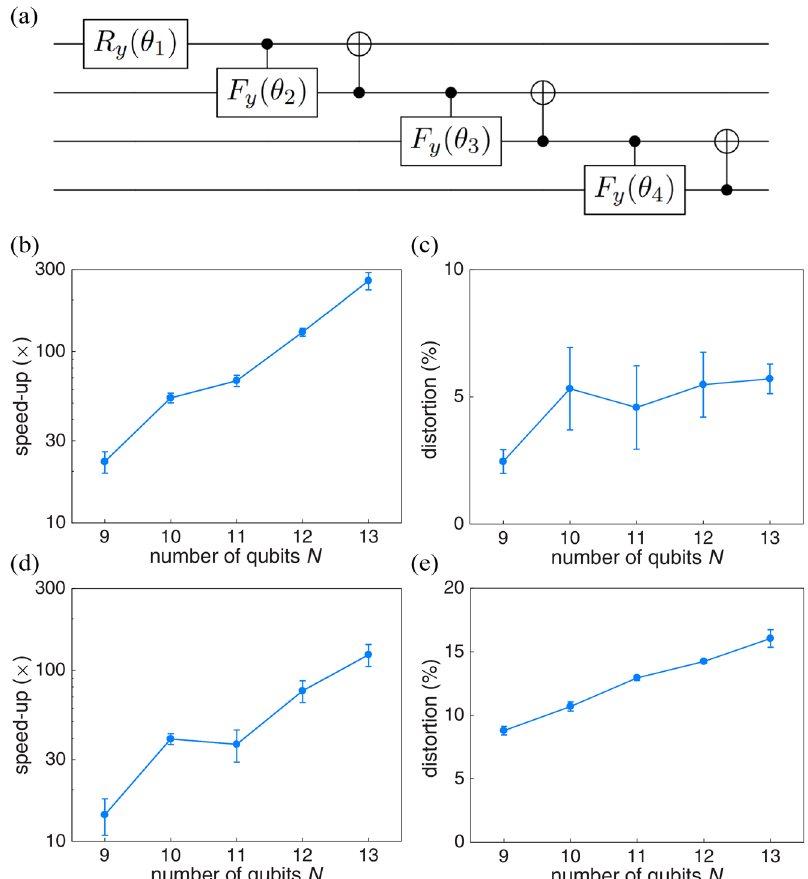
Fig. 9 Results of state preparation under depolarizing noise. a Circuit for state preparation with four qubits as an example. b , c Speedup and distortion of the LRET method under sparse noise channels. d , e Speedup and distortion of LRET under dense noise channels. Parameters are p = 0.1% and ϵ = 10 − 4 . The error bars are standard-deviation-calculated across a set of